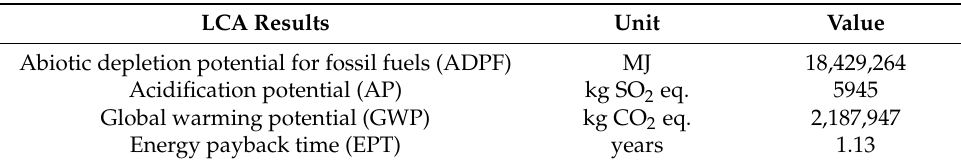
Table 5. Summary of